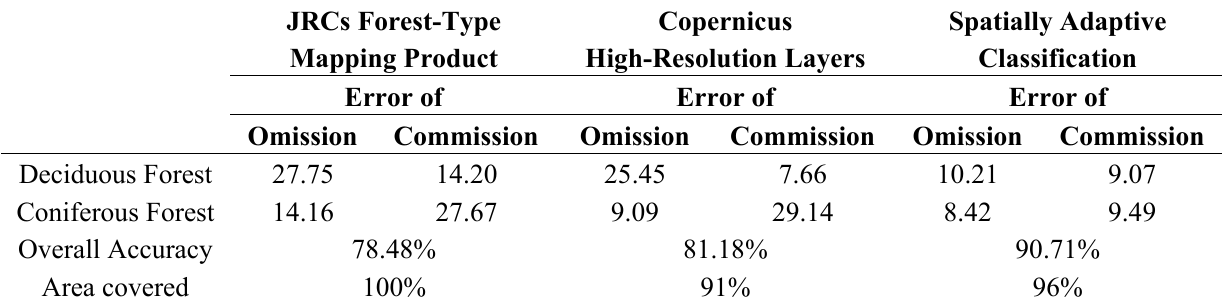
Table 3. Summary of forest-type validation (based on 4480 validation points).